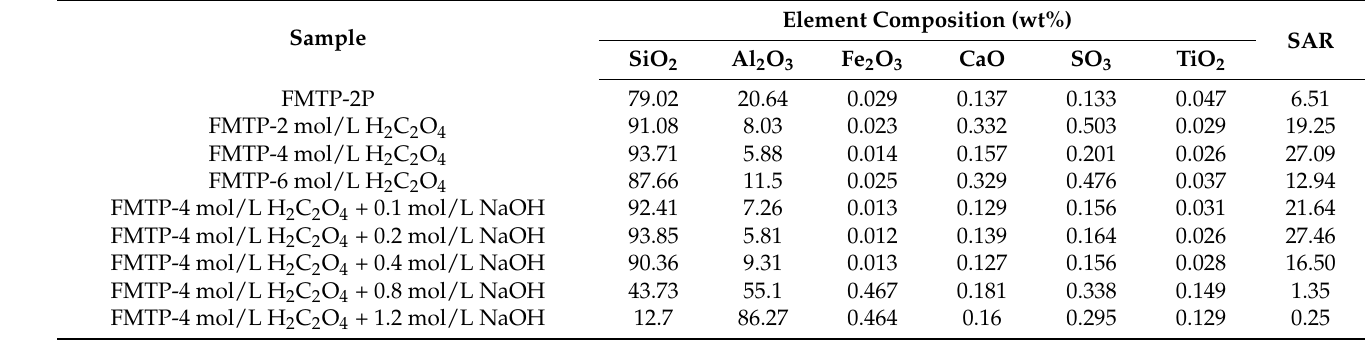
Table 2. Elemental composition and content of samples before and after alkali combined treatment of waste catalyst subjected to 4 mol/L H 2 C 2 O 4 acid